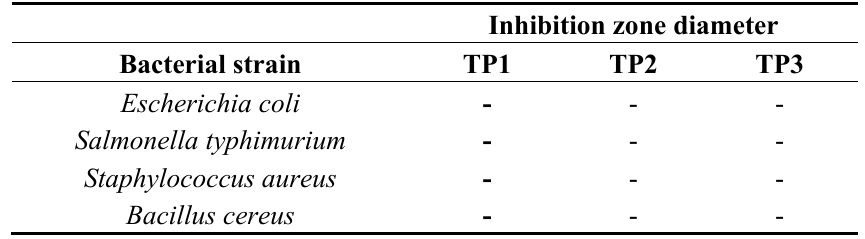
Table 3. Antibacterial activity of Trifolium pratense L . essential oil